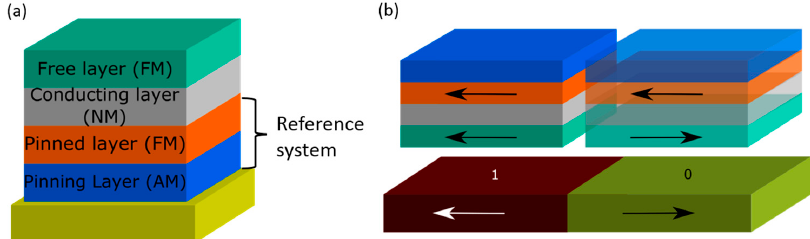
Figure 6. ( a ) Schematic setup of the stack configuration of a GMR spin-valve sensor; ( b ) Conceptual